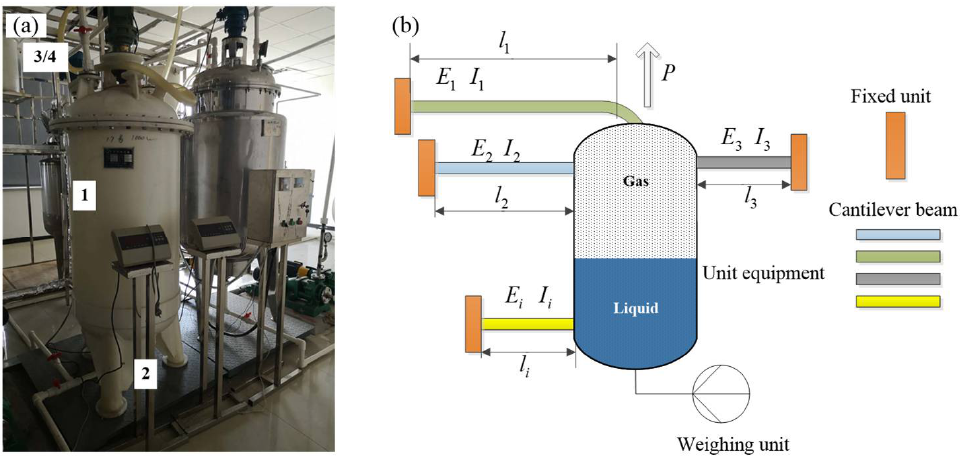
Figure 1. The material weighing system inside unit equipment with connected piping: ( a ) physical model; ( b ) system diagram.